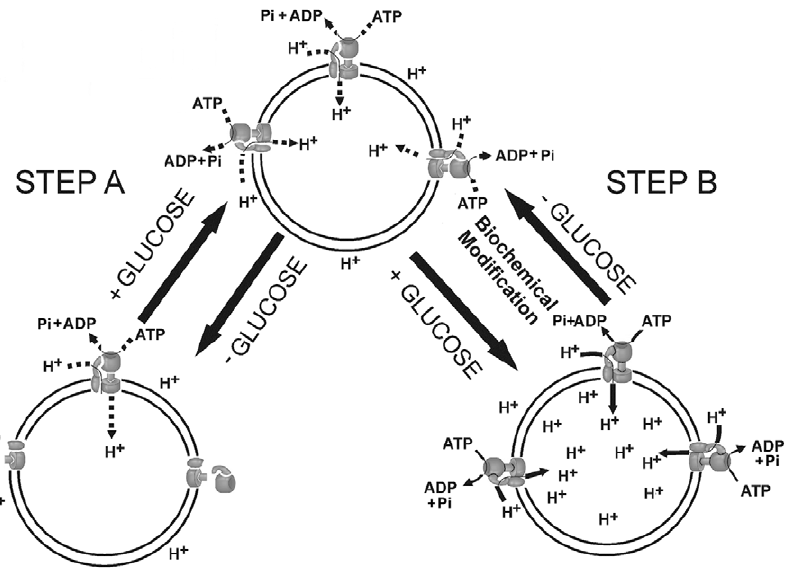
Figure 1. A model for the hypothetical regulation of V H + -ATPase activity by extracellular glucose. Step A: the dissociation and reassociation of the catalytic complex V 1 , according to [17,18]; alternative step B: a putative biochemical modification and conformational change of V 1 subunits (this report).